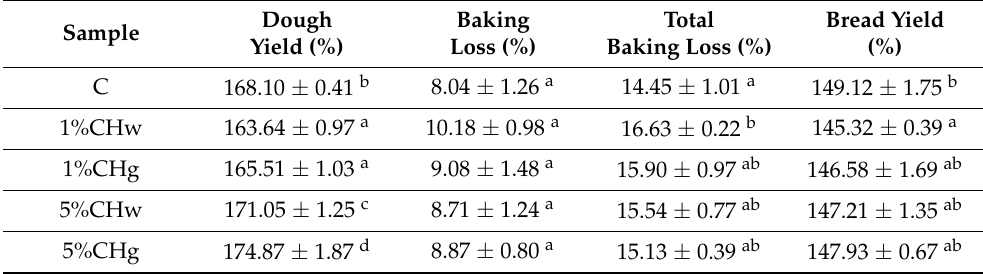
Table 2. Baking parameters of wheat bread with and without chia seeds.